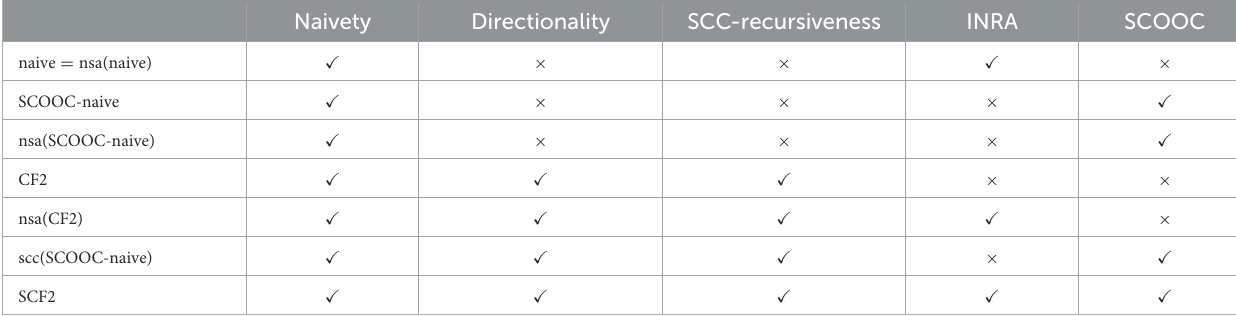
TABLE 2 Properties of SCF2 and six semantics that are related to it with respect the five principles considered in this article. Naivety Directionality SCC-recursiveness INRA